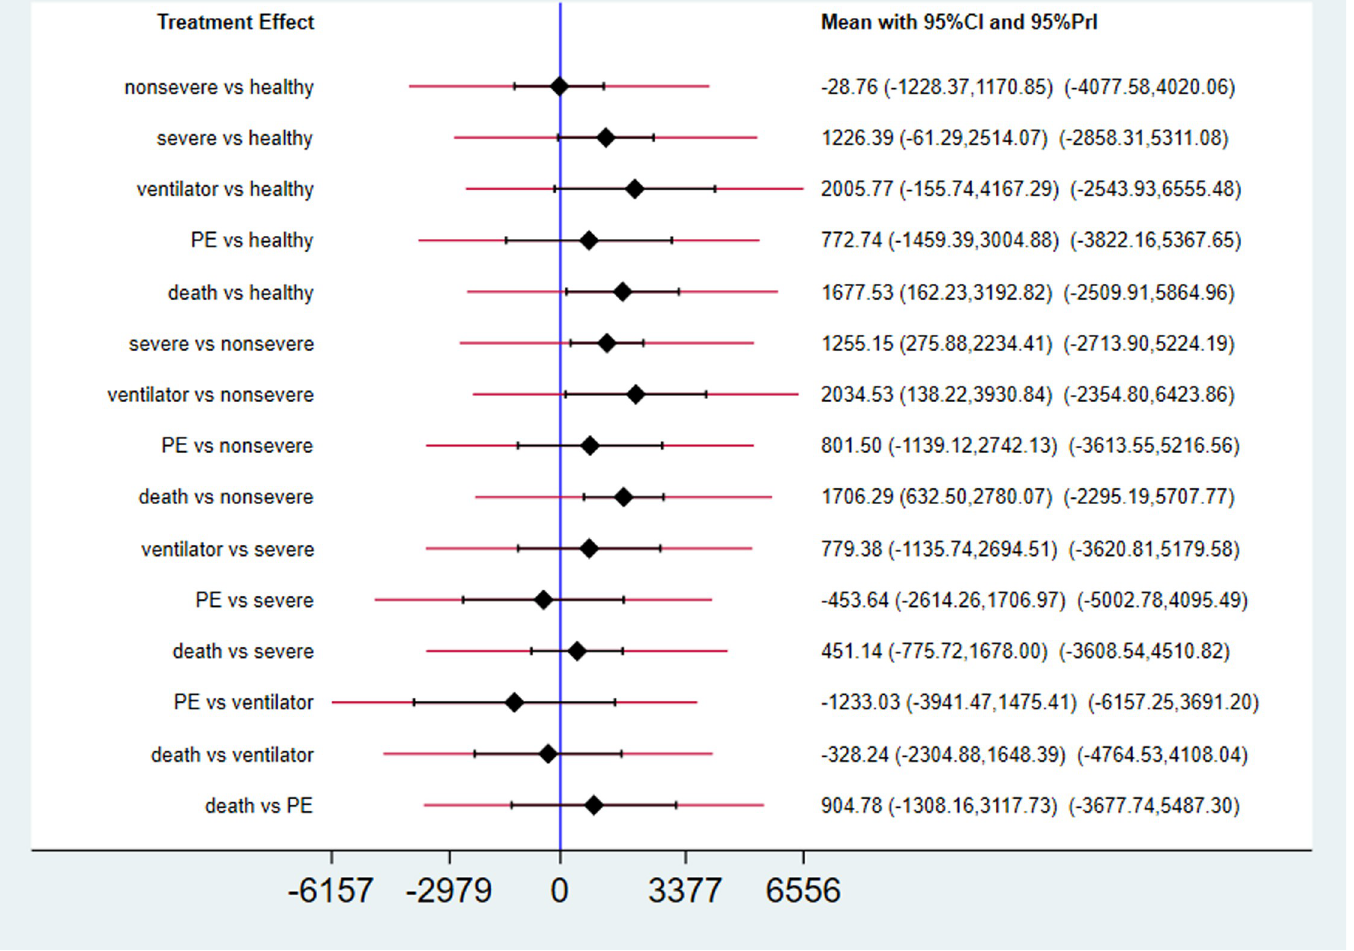
PLOS ONE | https://doi.org/10.1371/journal.pone.0263215 February 23,